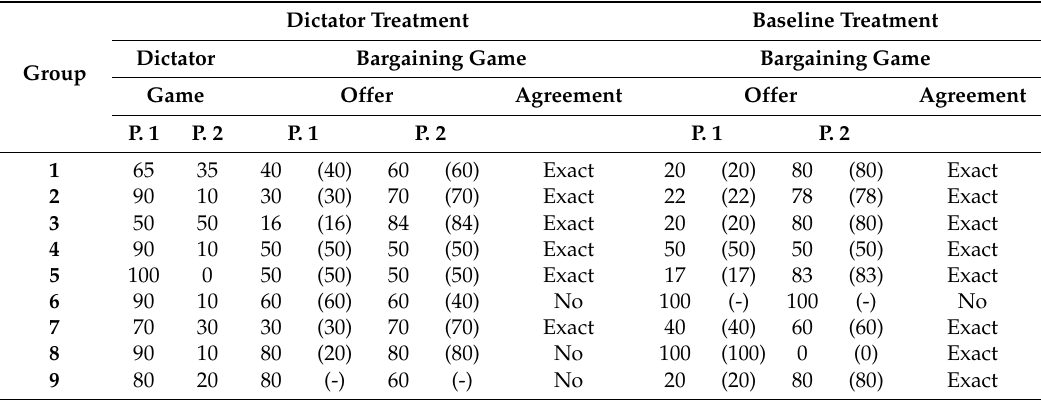
Table A1. Chat proposals (in brackets) and decisions per